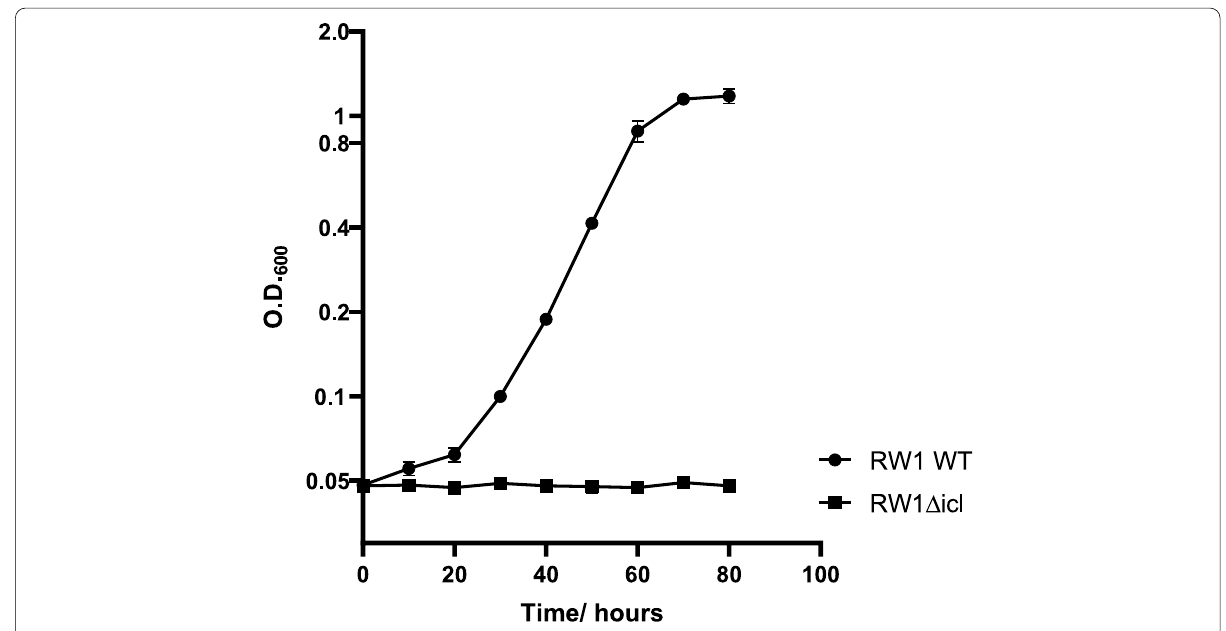
Fig. 2 Effect of icl deletion on growth of S. wittichii RW1 on 10 mM acetate